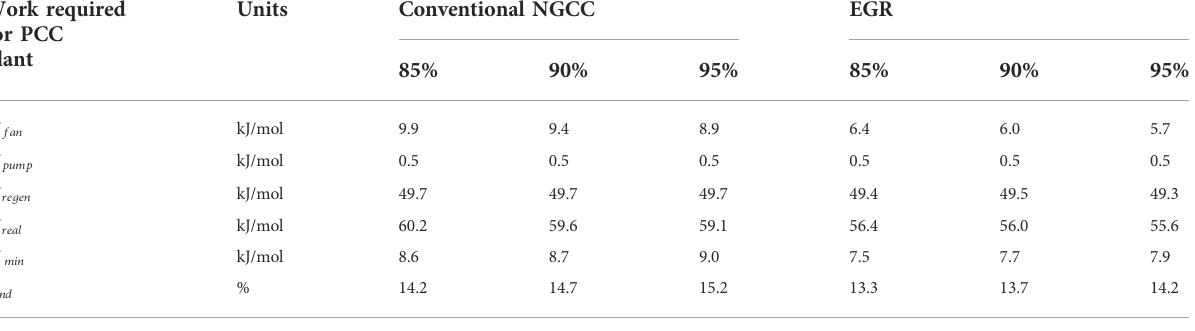
TABLE 3 Second-law ef fi ciency values for NGCC and EGR con fi guration at different capture levels (%). Work required for PCC